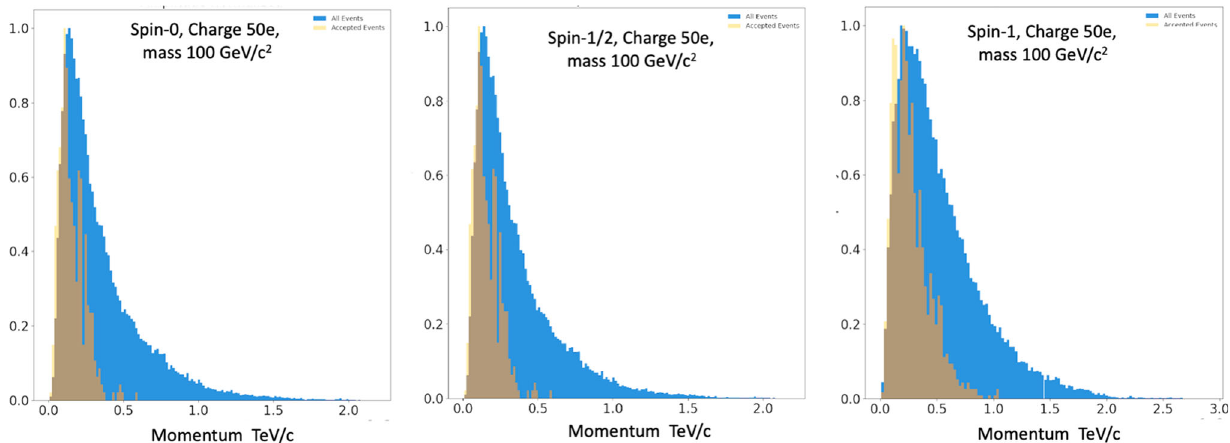
Fig. 15 The momentum distribution for HECOs of mass 100 GeV/c 2 producedviatheDYprocesswithvirtualphotonexchange,withelectric charge 50 e , for each spin assignment. In each case, 60K events were